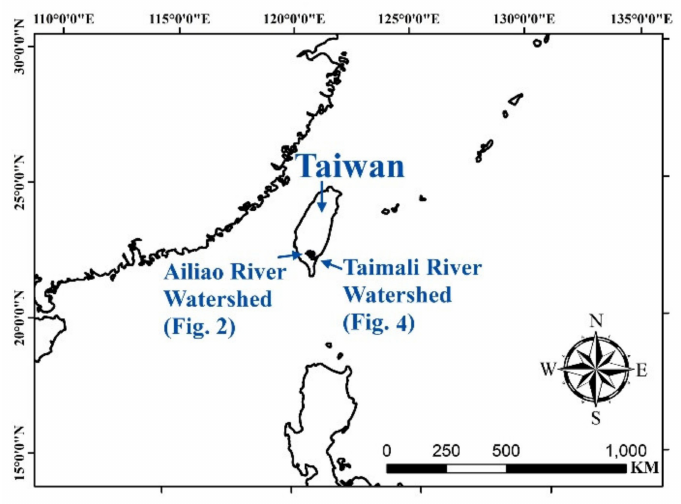
Figure 1. Location of Taiwan, Ailiao river watershed (abbreviated as ARW), and Taimali river watershed (abbreviated as TRW).